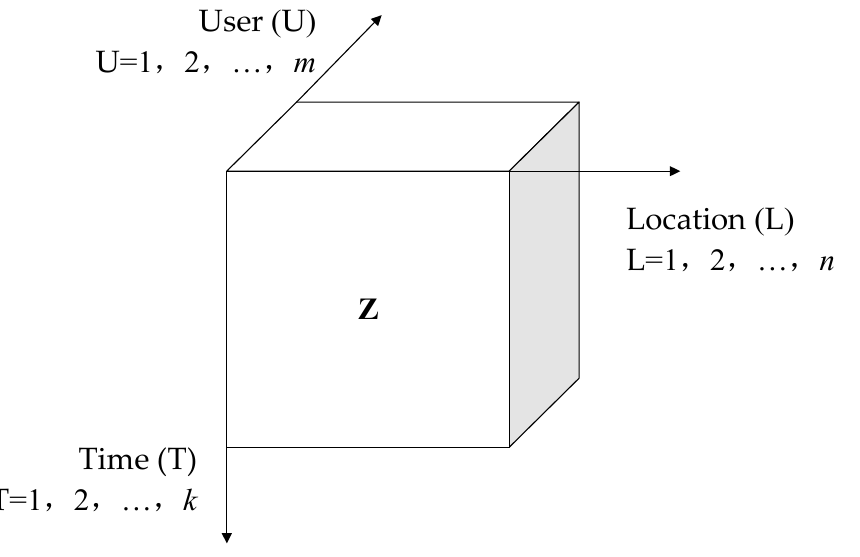
Figure 4. U-L-T third-order tensor. The eigenvalues of the L dimension are the POI popularity values. At the user level, POI popularity is expressed as the ratio of the number of users who checked in at this POI to the total number of users; at the location level, POI popularity is represented by the ratio of the number of user check-ins at this POI to the total number of user check-ins at all POIs; at the time level, POI popularity is the ratio of the number of time slot types at which users check in at this POI to the total number of time slot types. By integrating the influences of user, location, and time contextual information on the check-ins of interest points, we express the POI popularity at location l j as p l , and its calculation Formula is (11). j